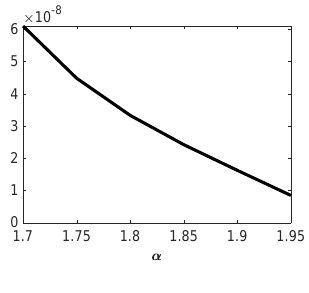
Figure 6. The absolute maximum error of w ( x,t ) for different α in example 2. T = 0 . 1 and ∆t = 10 − 4 are